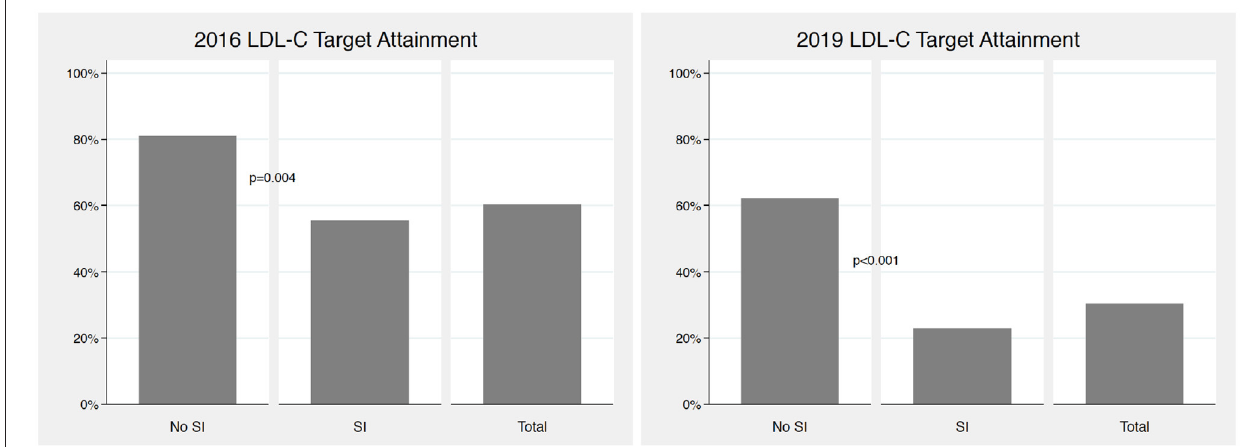
FIGURE 2 | 2016 and 2019 ESC/EAS guidelines LDL-C target attainment according to the presence of statin intolerance. LDL-C, low-density lipoprotein cholesterol; ESC, European Society of Cardiology; EAS, European Atherosclerosis Society; SI, statin intolerance; both p -values for the comparisons of LDL-C target attainment in patients with vs. without SI.